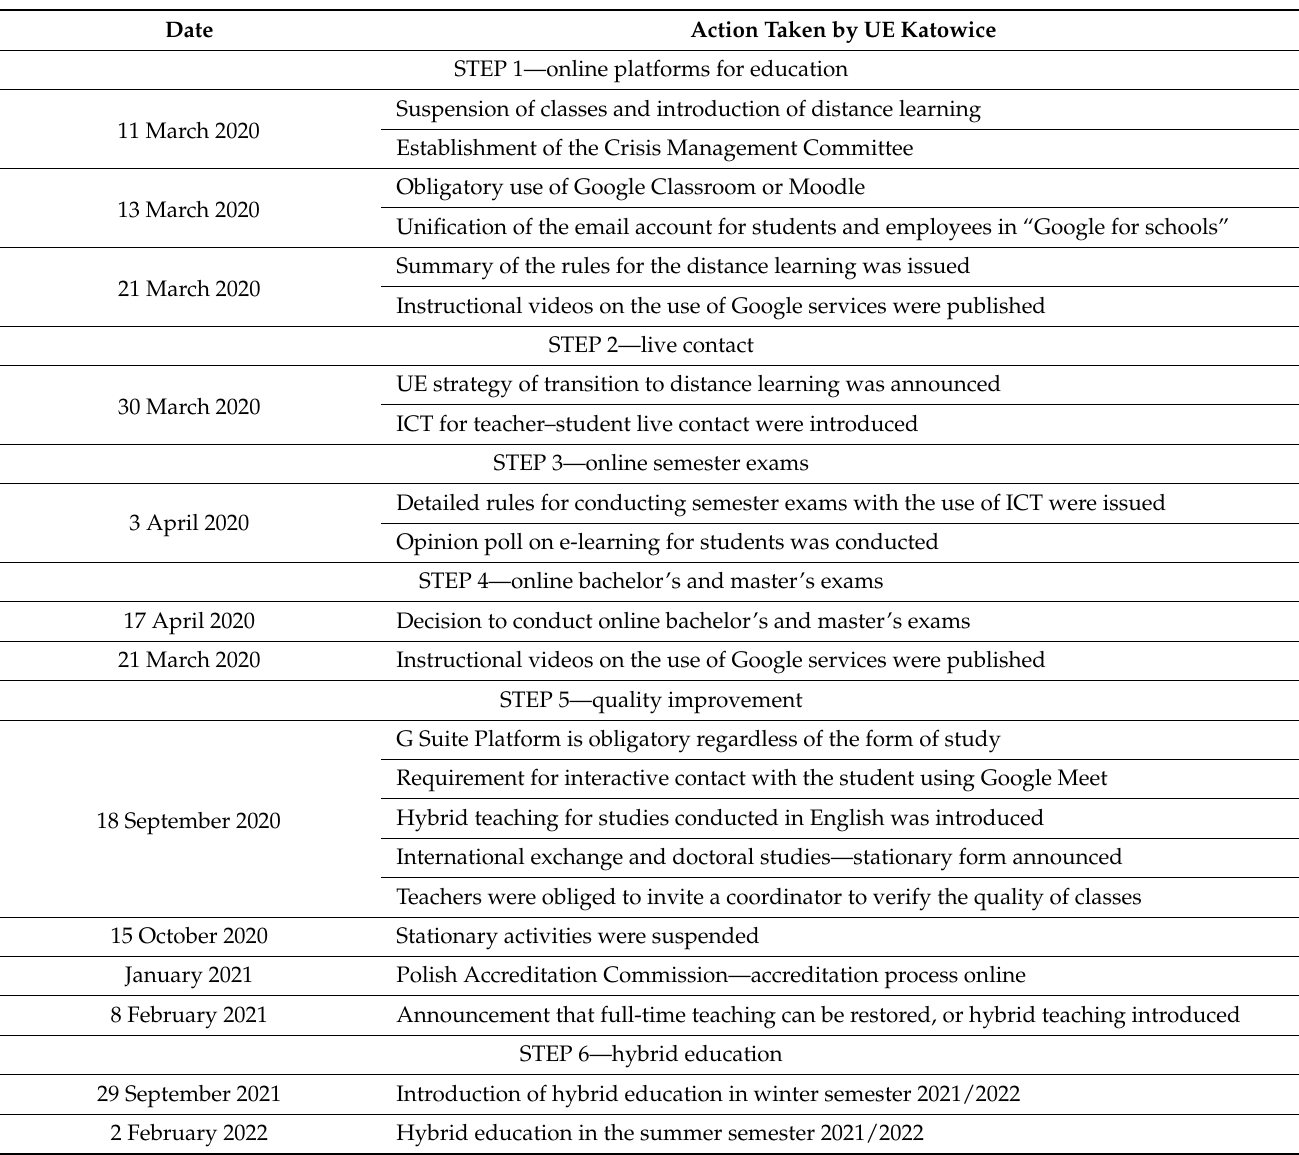
Table 3. Time-lined steps of distance learning introduced at the University of Economics in Katowice, Poland, according to governmental and institutional